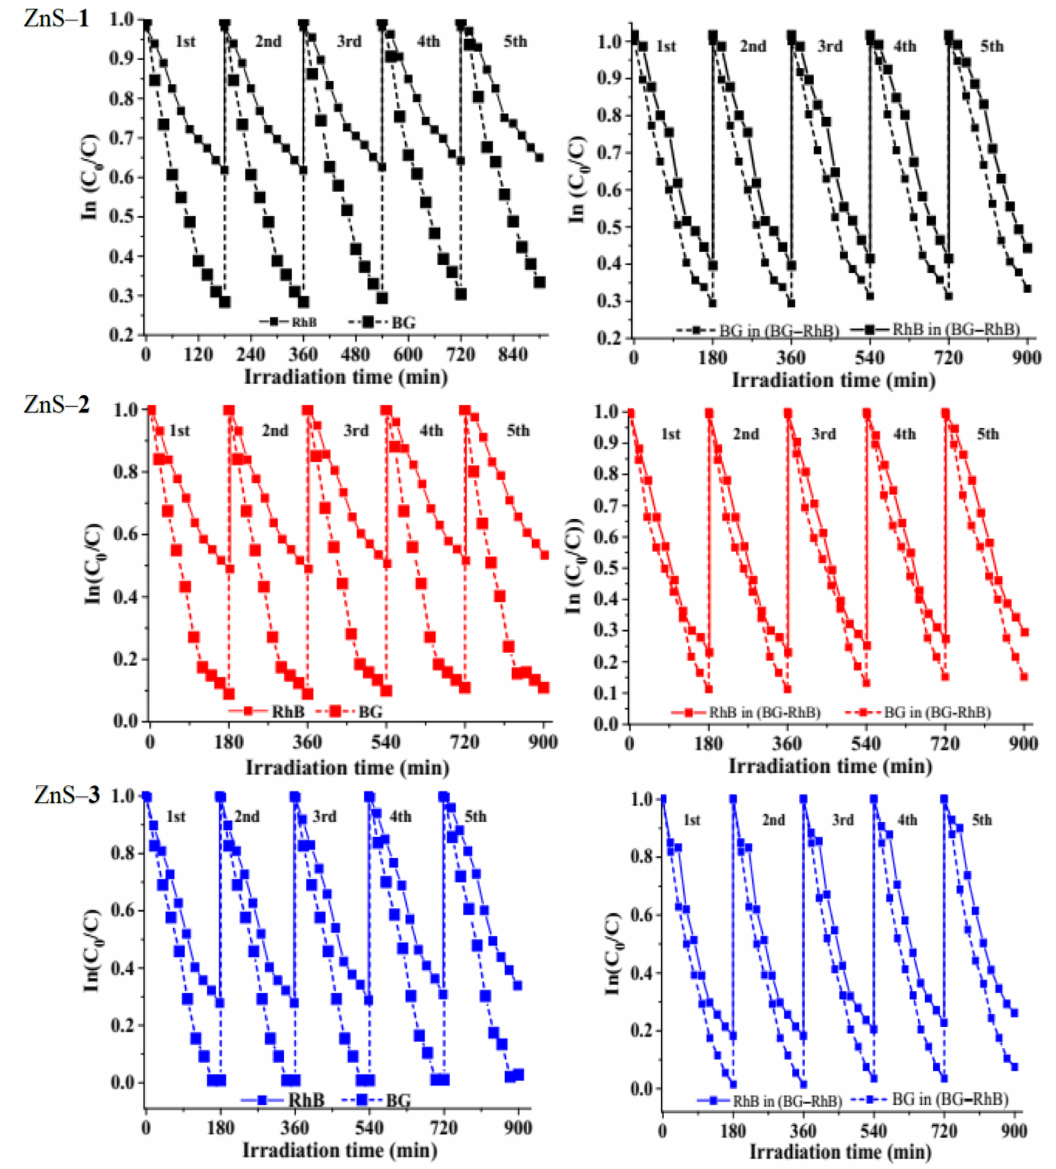
Figure 8. Reusability test of as-prepared ZnS catalysts on brilliant green (BG), rhodamine b (RhB), and binary